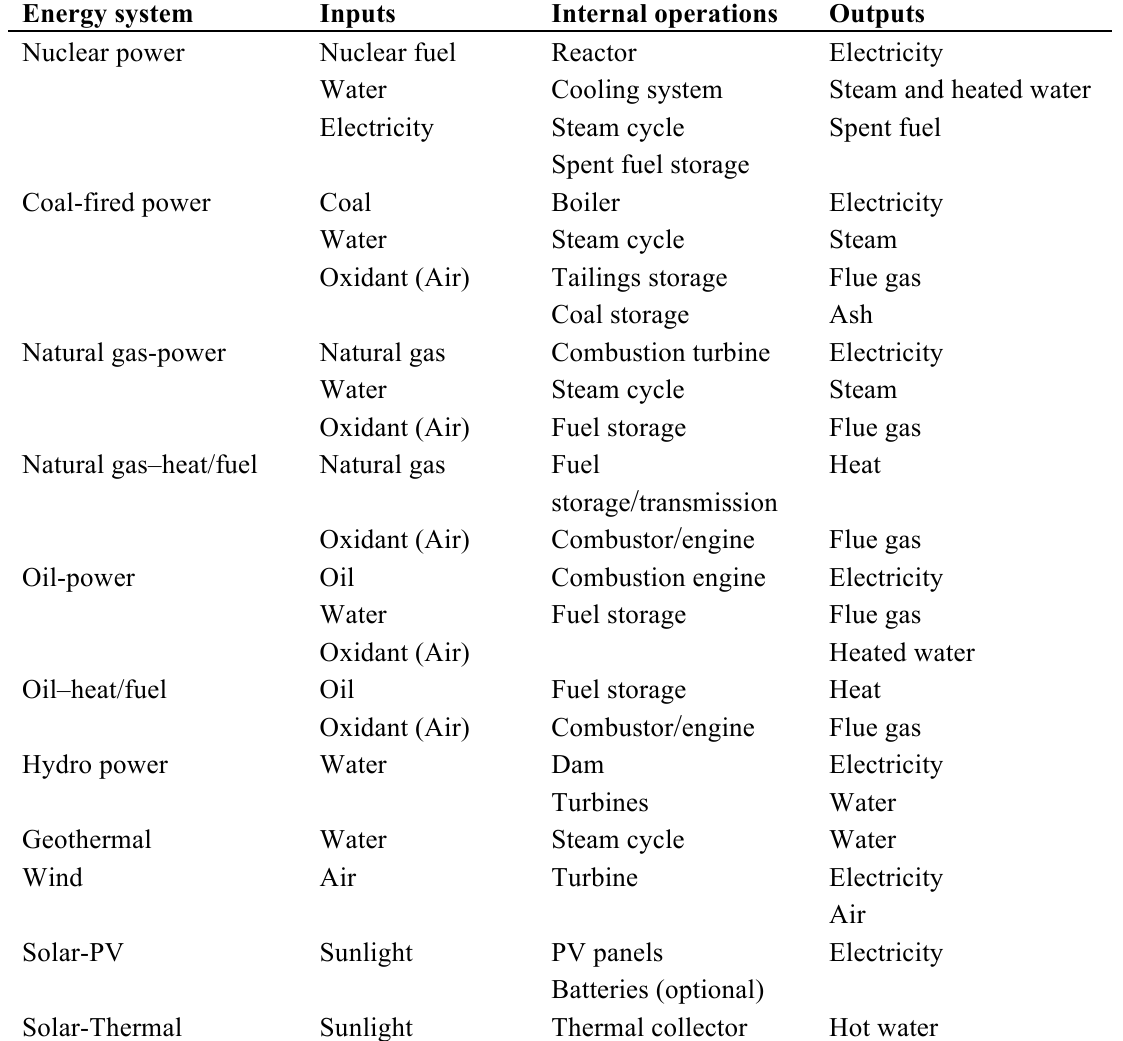
Table 2. Inputs-internal operations-outputs for alternative energy systems and